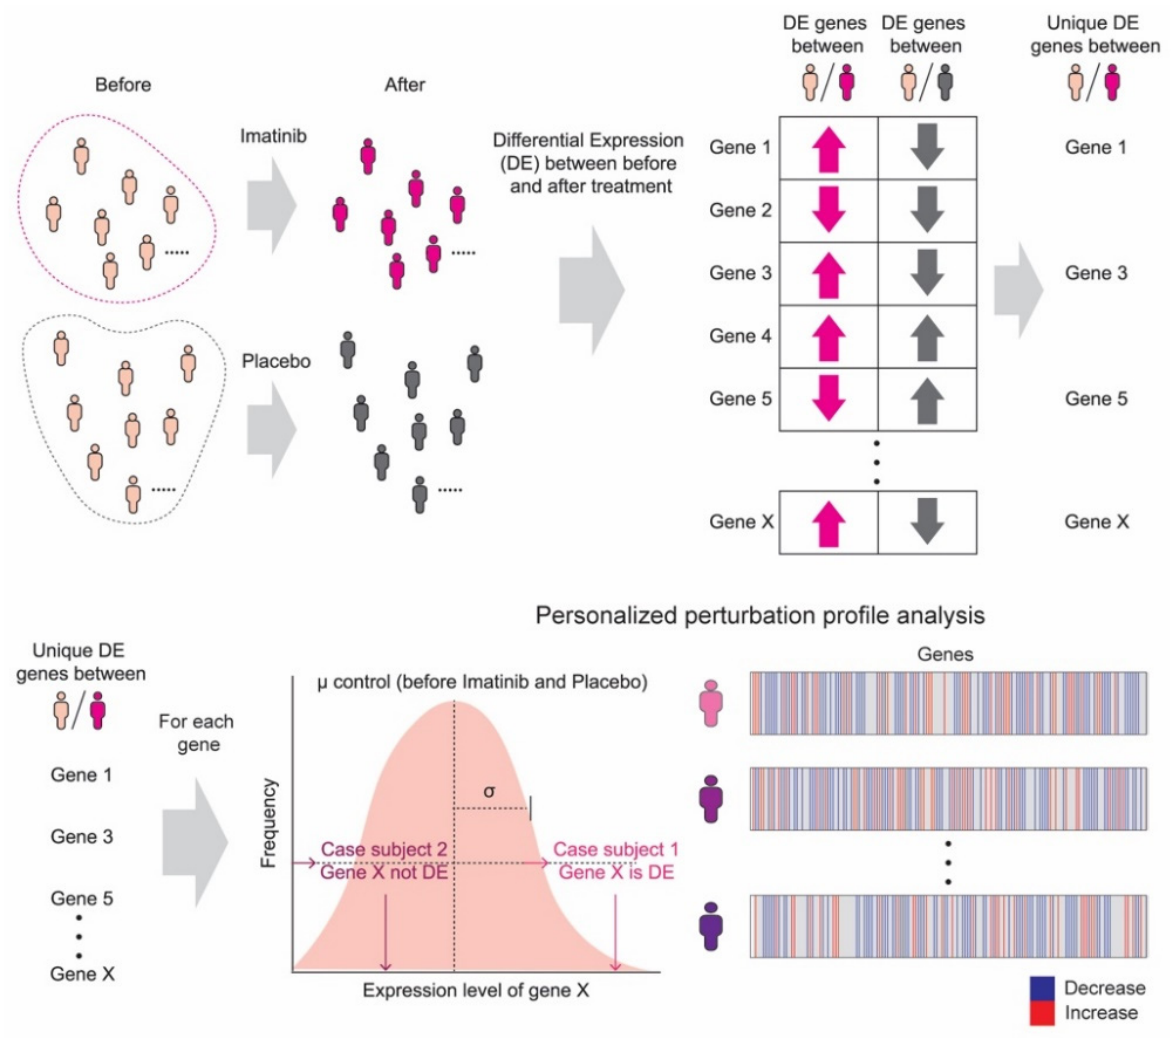
Figure 1. Personalized perturbation profile (PEEP) analysis pipeline. PEEP compares gene expression changes post-treatment at the level of single individuals, to baseline gene expression in a pre-treatment patient population.